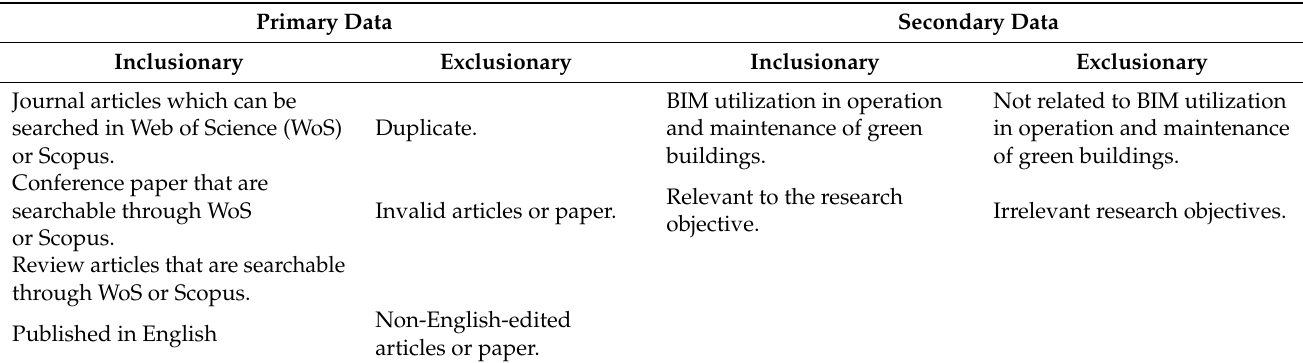
Table 2. Inclusion criteria and exclusion